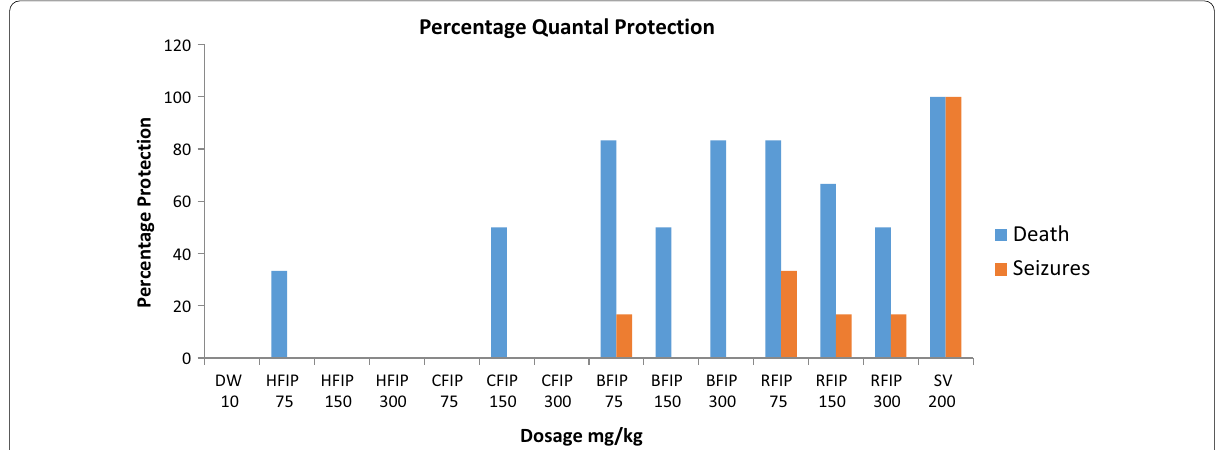
Fig. 3 The quantal protection effect of fractions of Ipomoea asarifolia on PTZ-induced seizure in mice. DW, Distilled water; HFIP, n -hexane fraction; CFIP, chloroform fraction; BFIP, n -butanol fraction; RFIP, residual aqueous fraction; SV, sodium